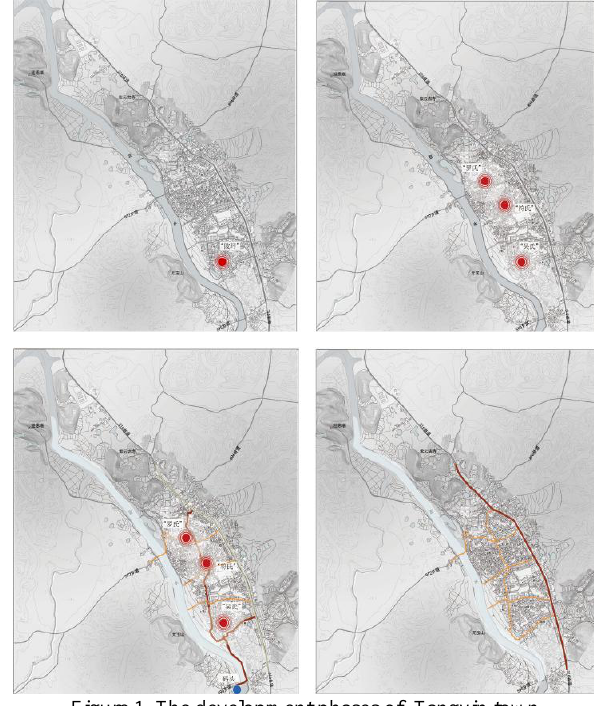
Figure 1. The development phases of Tangyin town 2.2 The natural appearance of the basement According to fengshui, the residents built dwellings with well implied meaning. Predecessors constructed in their selected address point successively, which formed to be "he